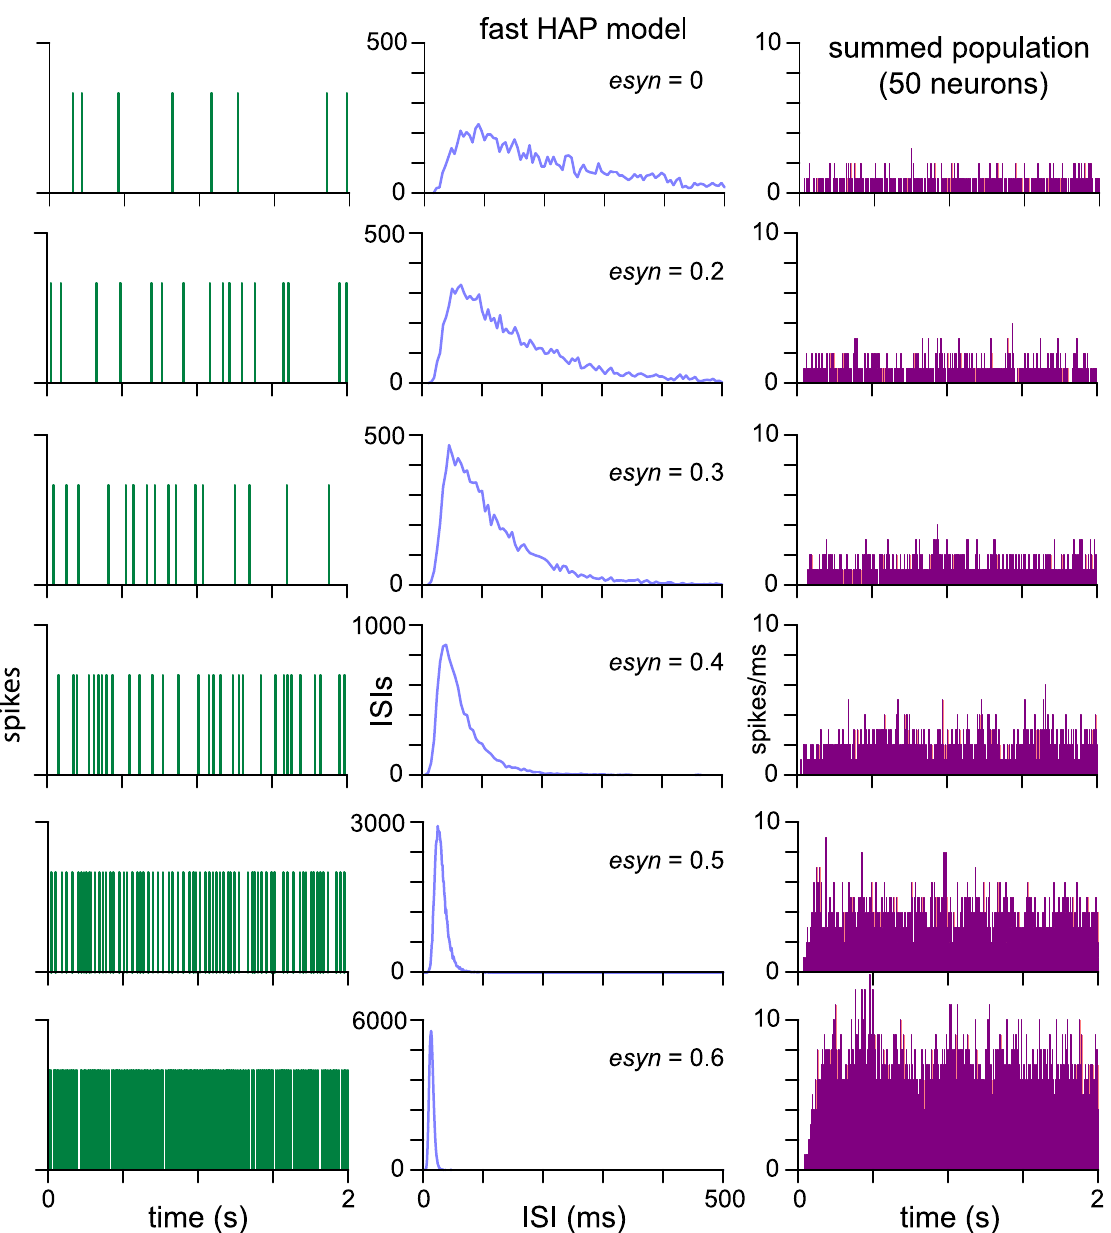
Fig 6. Increasing connection density in an excitatory ‘fast HAP’ network. Each row illustrates a single network model of 50 slow HAP neurons, with connection probability ( esyn ) increasing down the rows. All other neuron model parameters are fixed. In each row, the first 1 and second columns show the spiking and ISI distribution for one neuron in the network. Neurons within each network show very similar patterning, with some small variation due to the random connections and random external input signal. The third column shows the summed activity of all neurons in the network. As esyn 1 increases, the spike rate increases, the ISI distribution becomes less skewed and the amplitude of the mode increases, but there is otherwise no change in spike patterning. At higher connectivity the summed population activity (right column) shows the shift from slow to fast spiking sustained by the